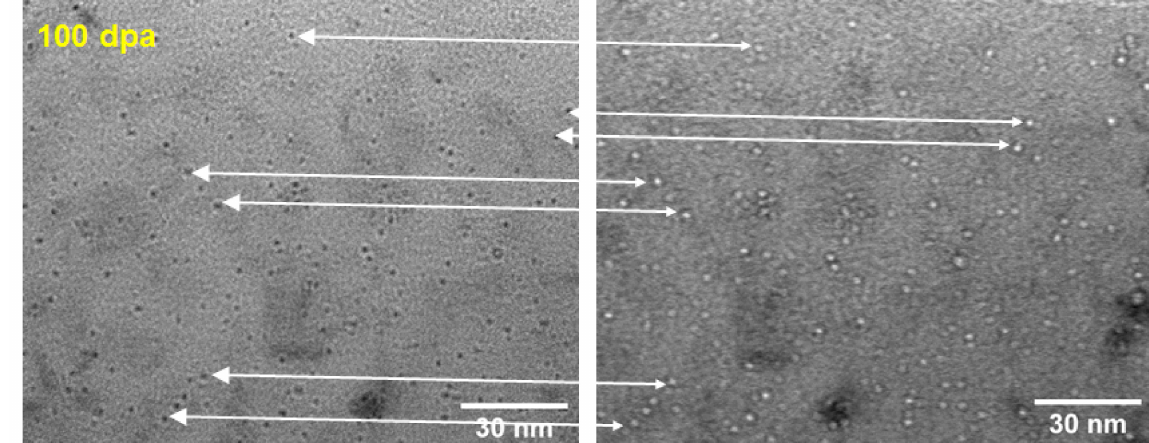
Figure 21. Under- and over-focused TEM image pair revealing readily apparent population of cavities in the 100 dpa FTT